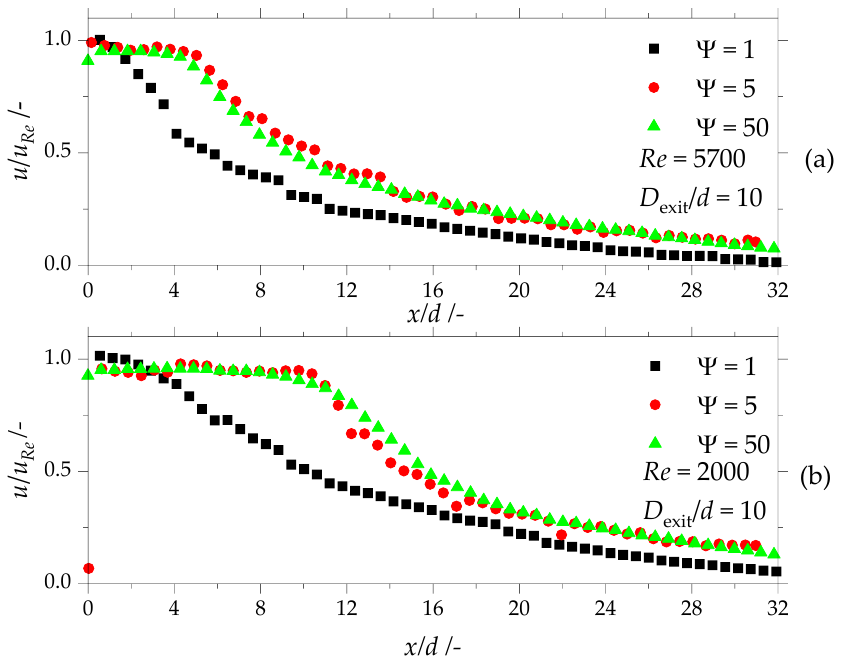
Figure 7. ( a ) Normalized velocity on the center axis at a Reynolds number Re = 5700 at the outlet of an orifice ( Ψ = 1 ) , of a 5-fold scaled orifice ( Ψ = 5 ) and of a 50-fold scaled orifice ( Ψ = 50 ) with an outlet channel diameter ratio of D exit / d = 10; ( b ) normalized velocity on the center axis at a Reynolds number Re = 2000 at the outlet of an orifice ( Ψ = 1 ) , of a 5-fold scaled orifice ( Ψ = 5 ) and of a 50-fold scaled orifice ( Ψ = 50 ) with an outlet channel diameter ratio of D exit / d = 10 .